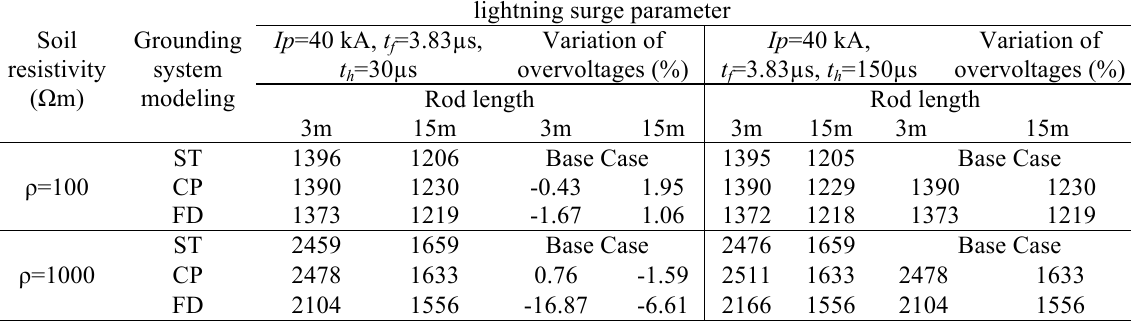
Table 6: Maximum voltage across the insulator string (kV) for Rod-shape grounding